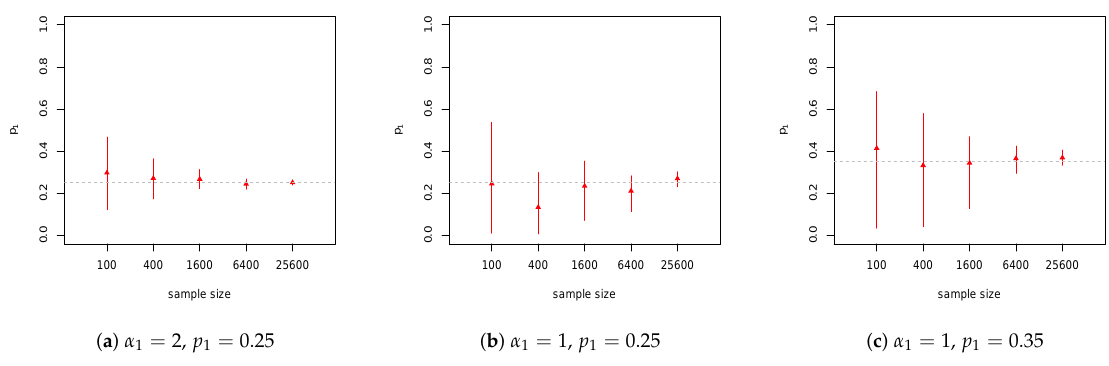
Figure 4. Credible intervals for the misrepresentation probability p 1 for the lognormal loss severity